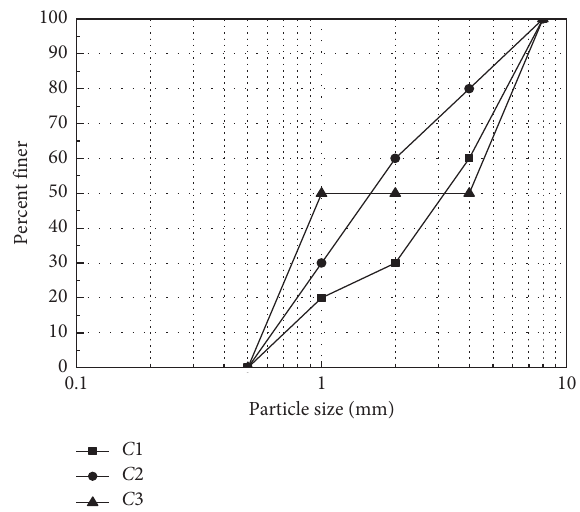
Figure 1: Particle-size distribution curves for the test